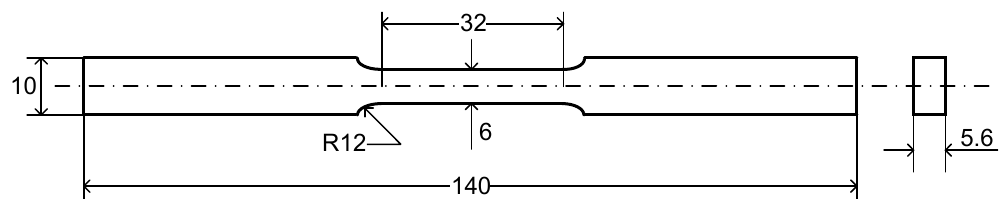
Figure 1. Geometry and dimensions of tensile and fatigue test specimens (all dimensions are in mm).